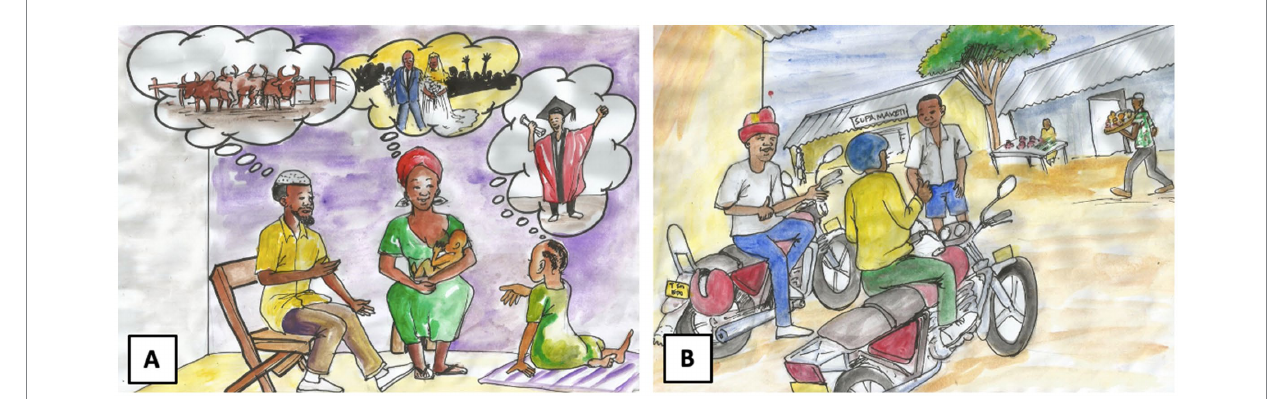
FIGURE 1 Storyboard images of learning initiative on norms, exploitation, and abuse (LINEA) radio drama characters: On the left, the main adolescent girl character, Amali, navigates the expectations of her family members (A) . On the right, the main adult man character, Tuma, must resist peer pressure to avoid age-disparate transactional sex (ADTS) (B)